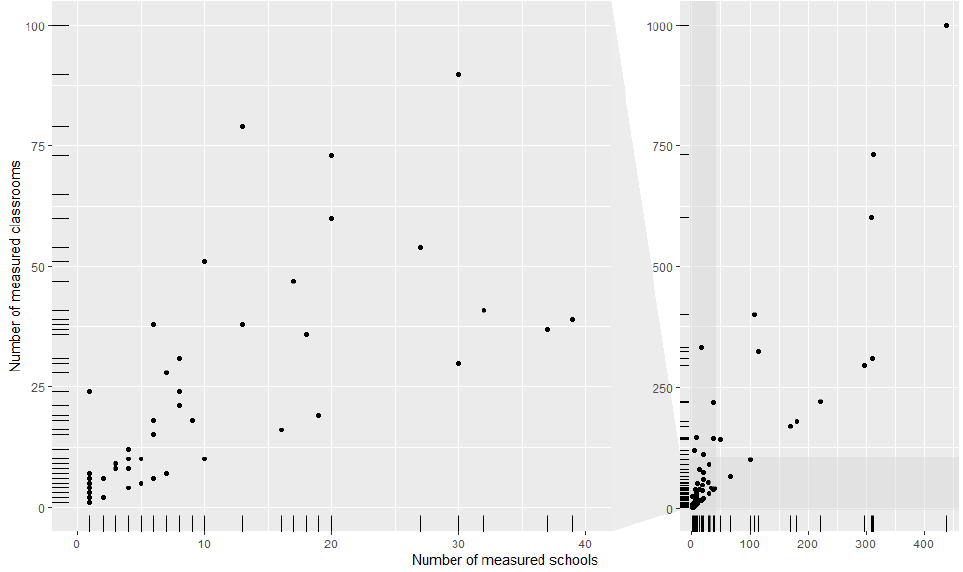
Figure 3. Number of schools and classrooms per study where the measurements were made. Each dot represents a study with the number of measured schools on the x-axis and the number of measured classrooms on the